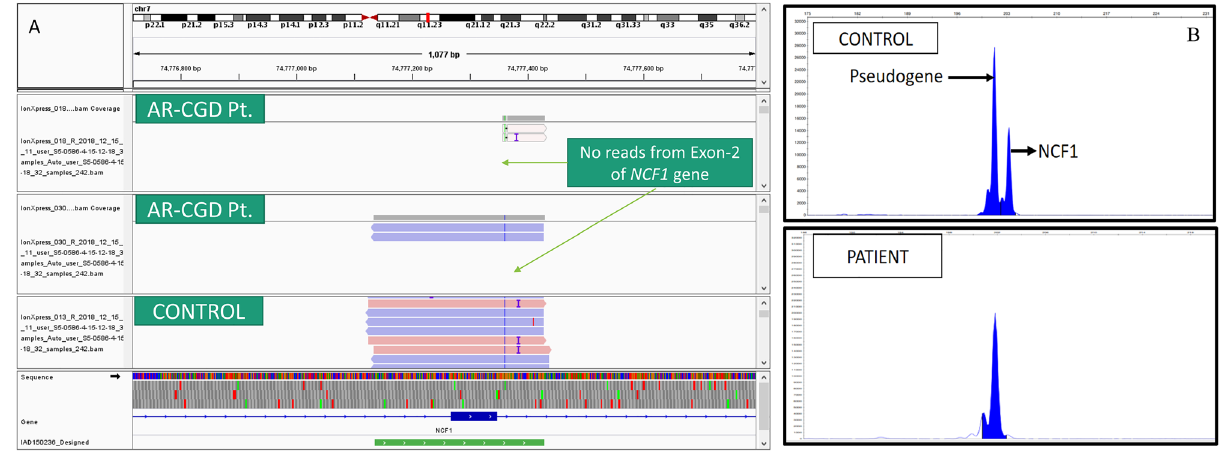
Figure 3. ( A ) IGV snapshot showing no reads from Exon-2 of NCF1 gene in 2 patients with AR-CGD ( B ) Gene Scan for Exon 2 NCF1 gene from control and an AR-CGD patient with no reads from exon 2 of NCF 1